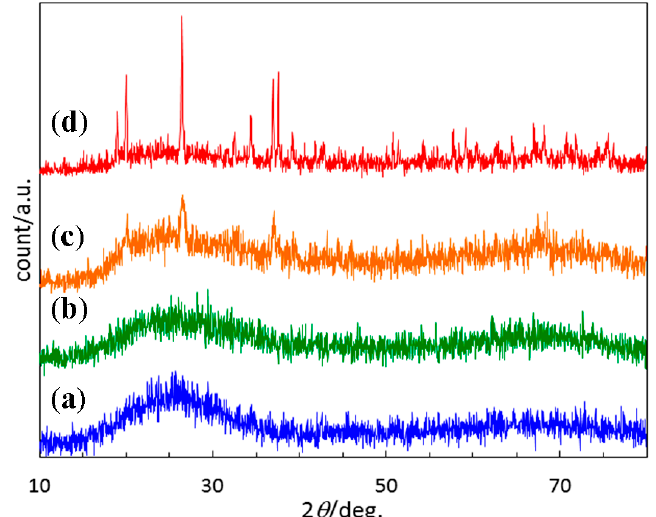
Figure 9. X-ray diffraction (XRD) patterns of ( a ) 800 °C-pyrolysed EtOSZ and the samples after the subsequent heat treatment at ( b ) 1400 °C; ( c ) 1600 °C; and ( d ) 1800 °C in N 2 .